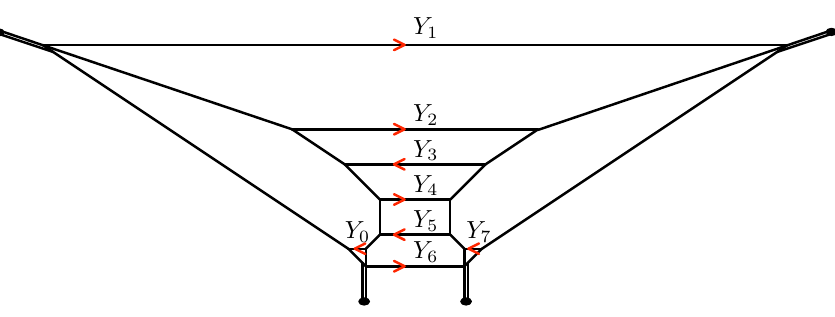
Figure 3 . A labeling of Young diagrams assigned to the horizontal edges of (cid:12)gure